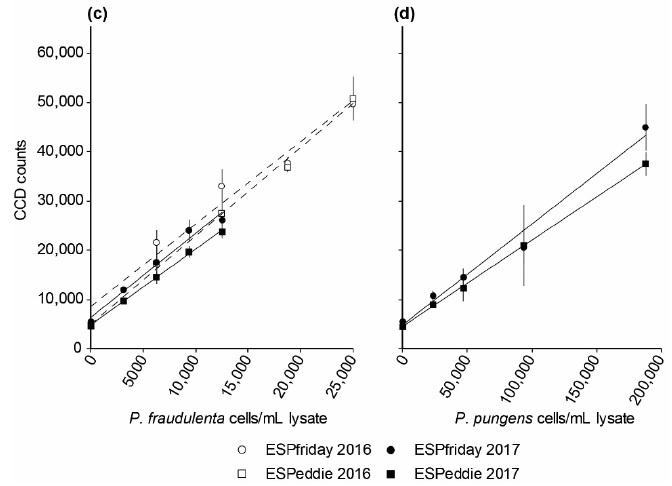
Figure 4. Harmful algal bloom (HAB) species calibration curves for ESPfriday and ESPeddie in 2016 and 2017: ( a ) P. australis auD1; ( b ) P. multiseries muD1; ( c ) P. fraudulenta frD2; ( d ) P. pungens pung1. Each point on the curve is the average spot intensity from 3 HAB arrays (± SD). Table 1. Linear regression coefficients for the model y = α + β x (where y is spot intensity and × is cells per mL lysate; n = 3 Figure 2. values for the harmful algal bloom (HAB) species calibration curves. Coefficients are given for curves generated in 2016 and 2017 on ESPfriday and ESPeddie for P. australis auD1, P. multiseries muD1, P. fraudulenta frD2, and P. pungens pung1. The lower limit of quantification (LLOQ) refers to the lowest cell concentrations (cells/mL lysate) that could be quantified.